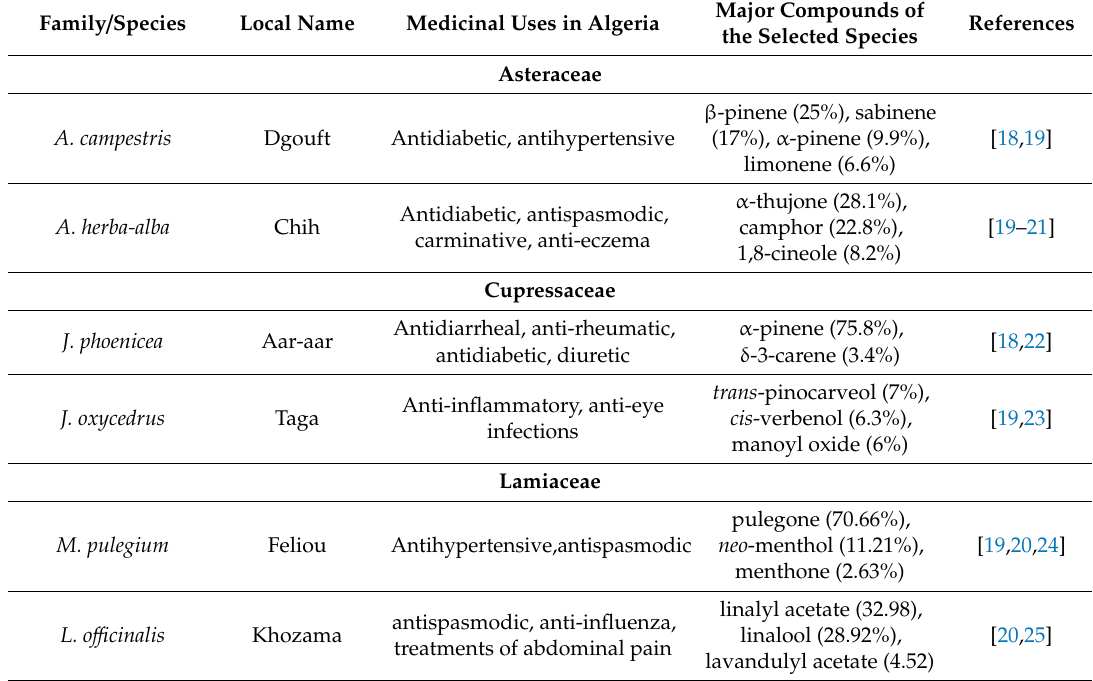
Table 1. Bibliographical overview of the popular names, traditional medicinal uses and main essential oils (EO) compounds of the Algerian species selected for the present